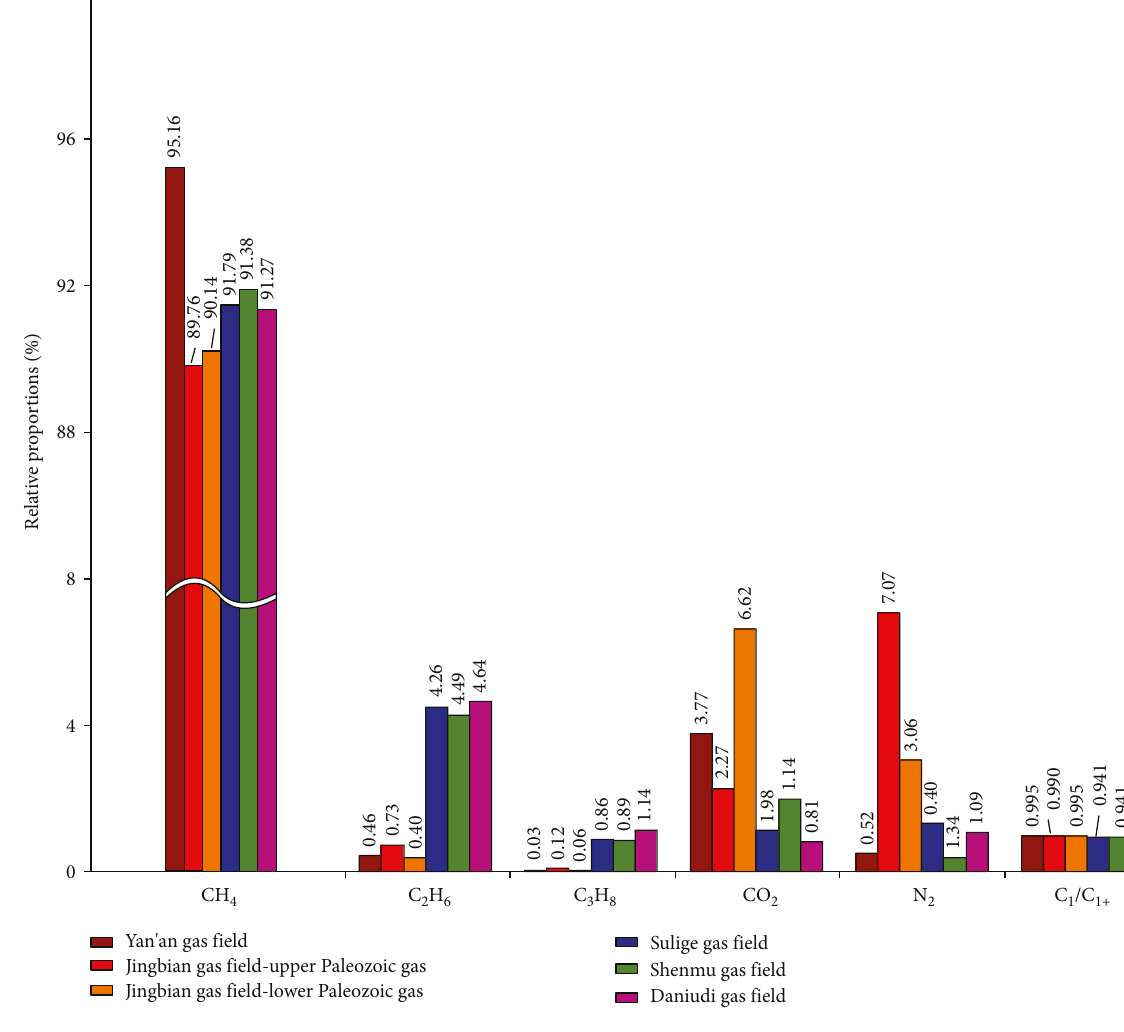
Figure 2: Relative proportions and dryness coe ffi cients of gas components of natural gas in gas fi elds of the Ordos